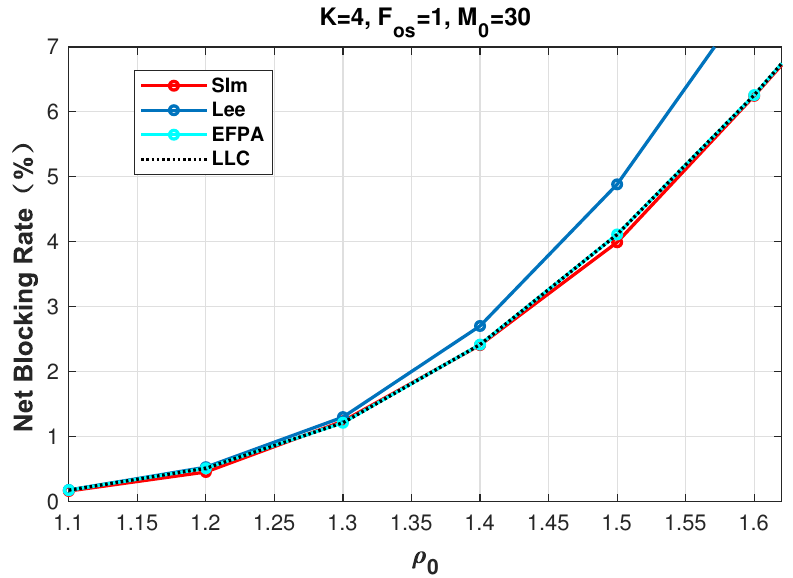
Figure 4. Network blocking performance of different methods with K = 4, F OS = 1, and M 0 = 30.